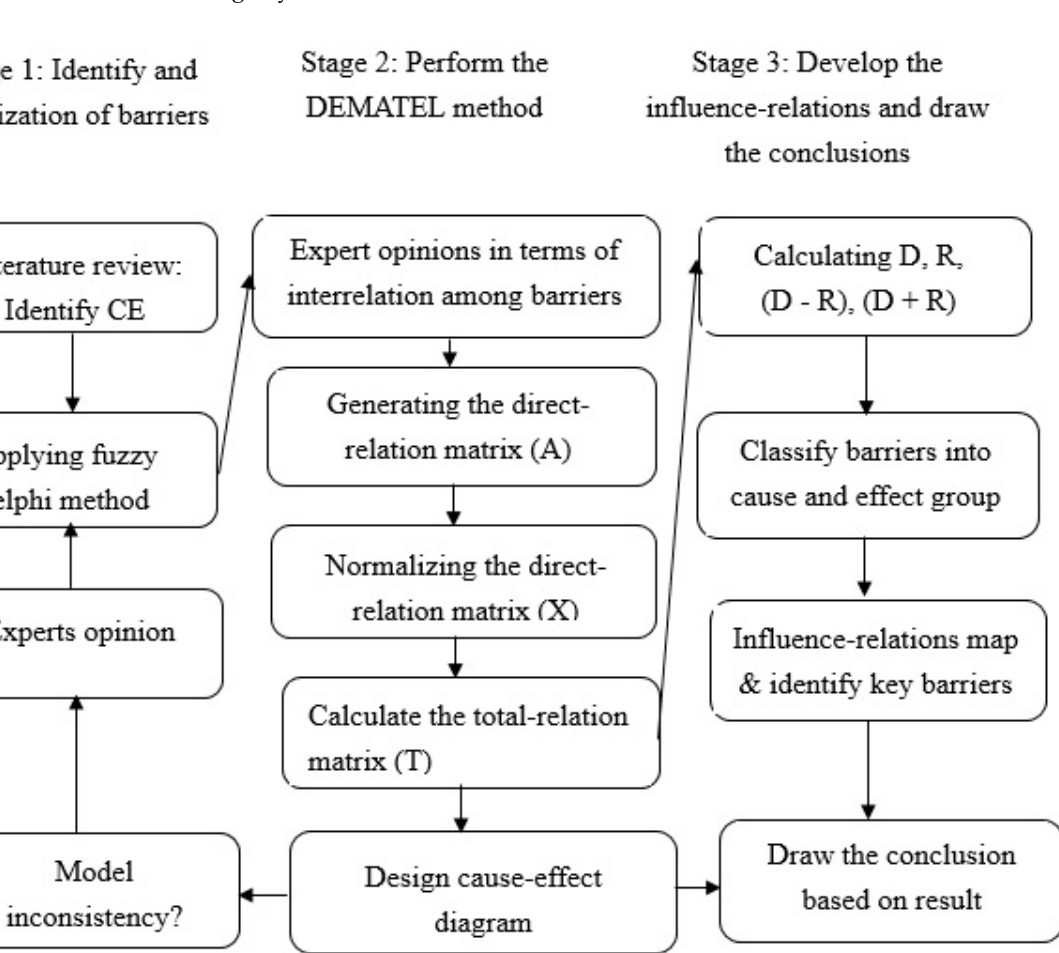
Figure 1. Research flowchart.